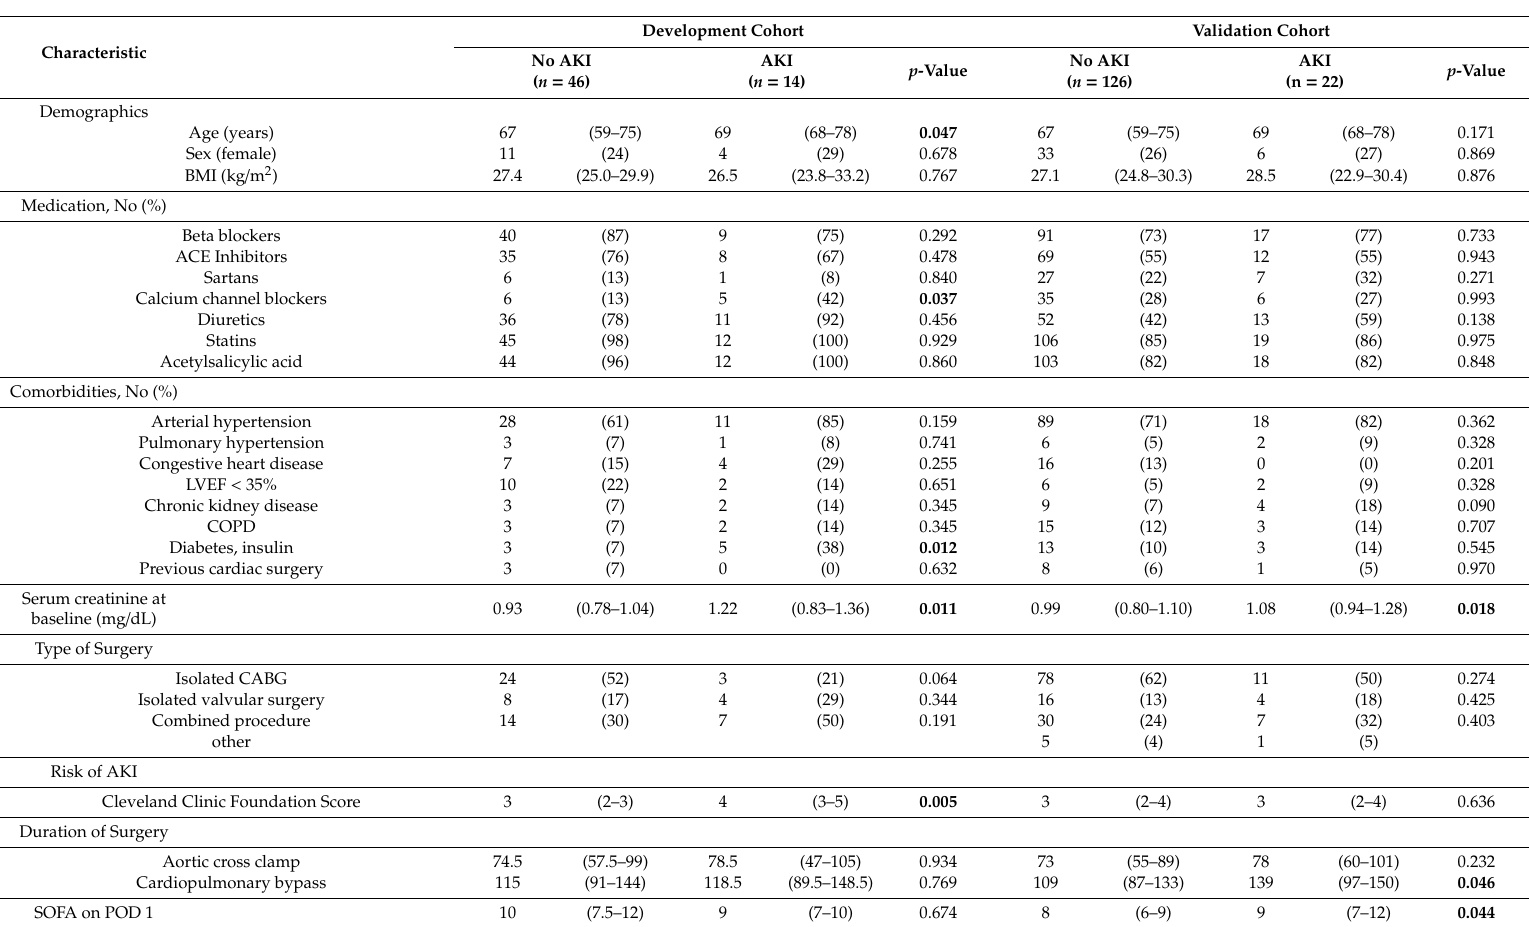
Table 2. Baseline and operative characteristics by cohort and AKI. Data are expressed as the median (Q1–Q3) or number (percentage). ACE, angiotensin-converting enzyme; AKI, acute kidney injury; BMI, body mass index; CABG, coronary artery bypass graft; COPD, chronic obstructive pulmonary disease; LVEF, left ventricular ejection fraction; POD1, first postoperative day; Q1, Q3, first and third quartile, respectively; and SOFA, Sequential Organ Failure Score. The influence of baseline characteristics on AKI was analyzed by univariable logistic regression. Bold fonts indicate p -values < 0.05.